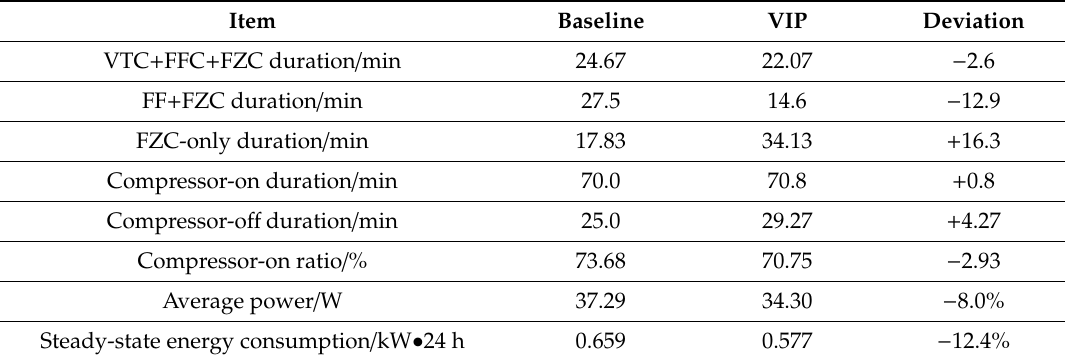
Table 3. Comparison of refrigerator performance between baseline and VIP